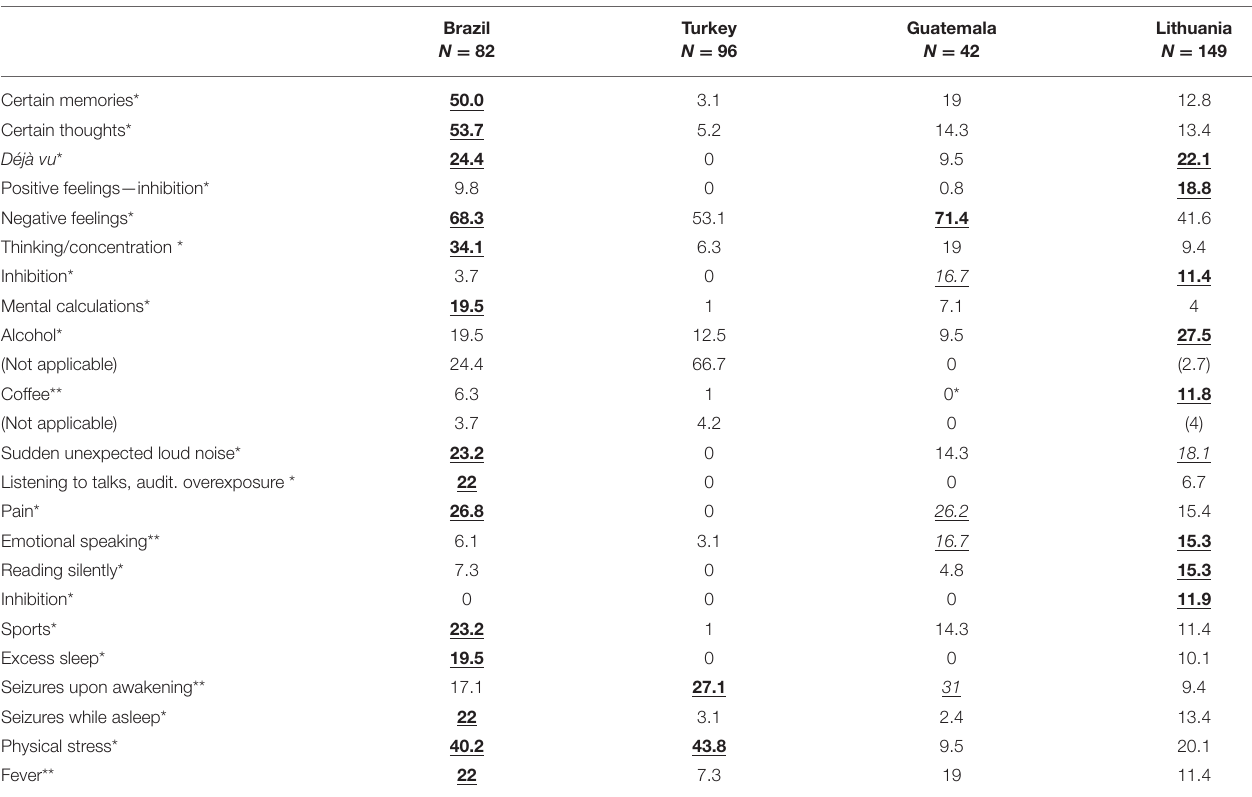
TABLE 7 | Discordant rates of attack modulatory factors in patients with epilepsy among the different countries.